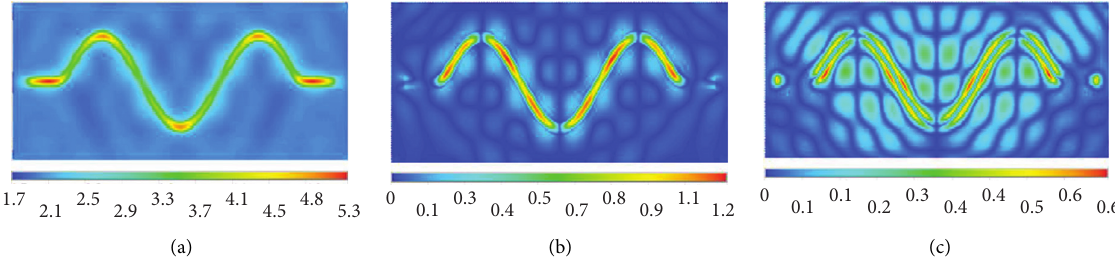
Figure 58: SV wave incident (NR � 3, f � 1.5Hz, H � 100m, and C